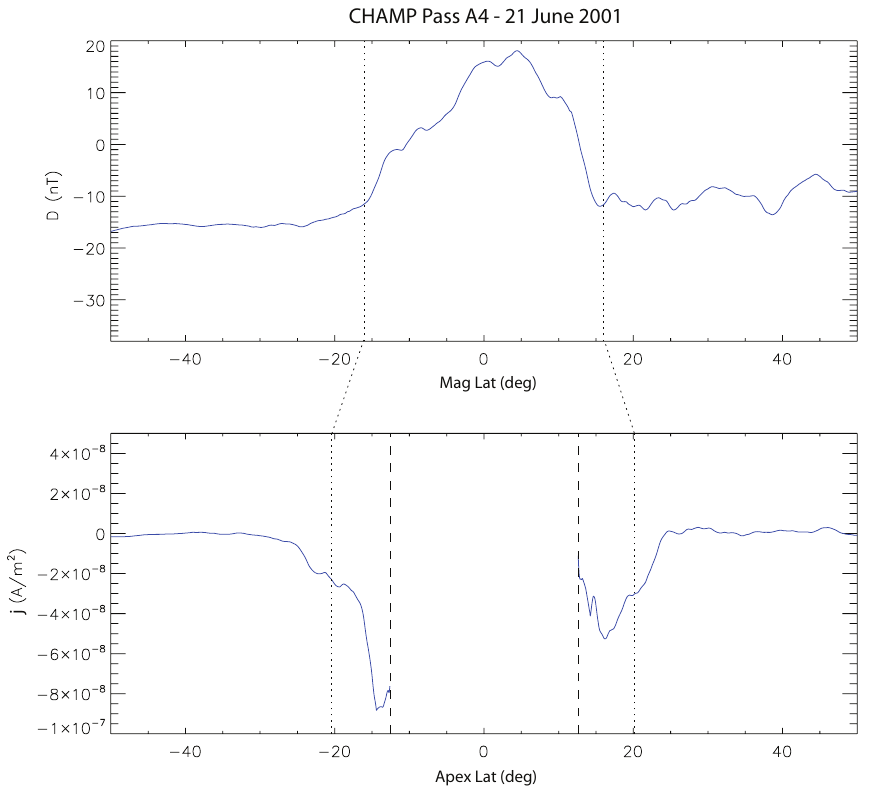
Fig. 7. The same as Fig. 5, but for the 21 June 2001 solar